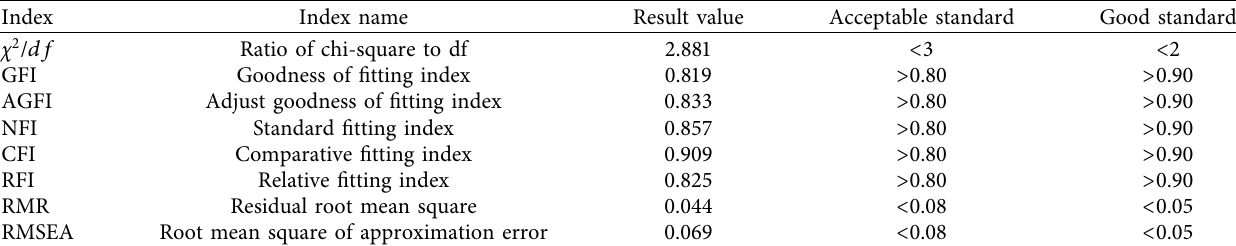
Table 9: Fitting results of